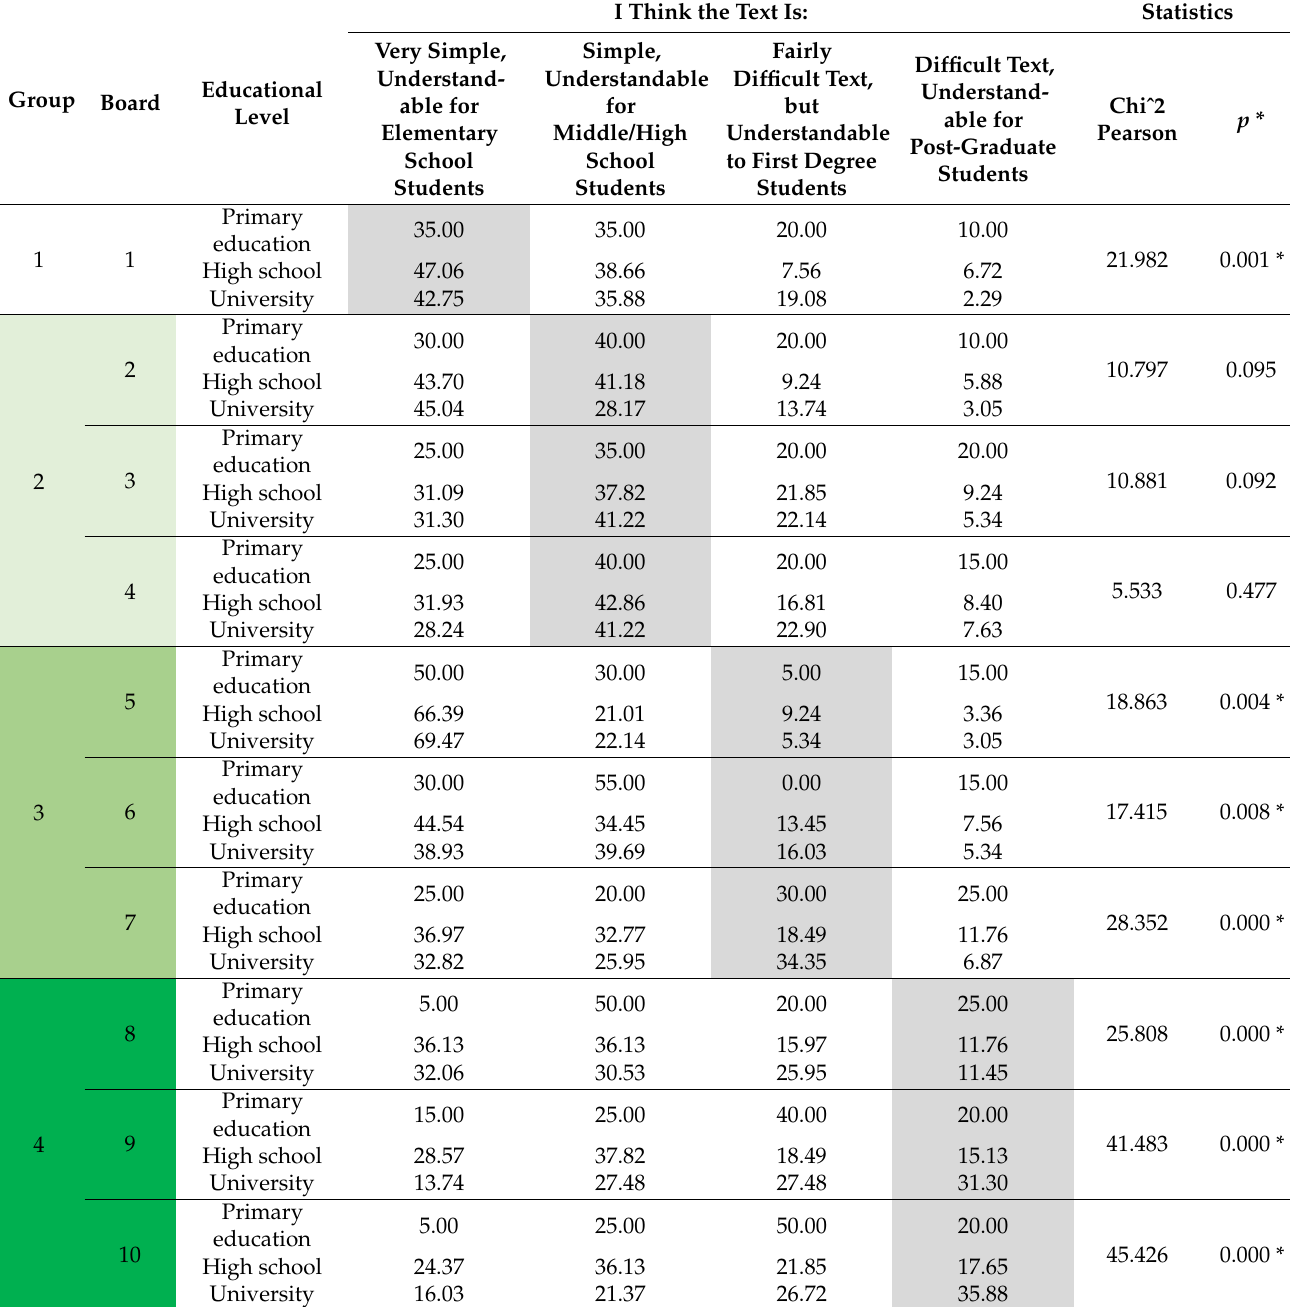
Table 7. Differences in ratings of text accessibility on educational boards by educational